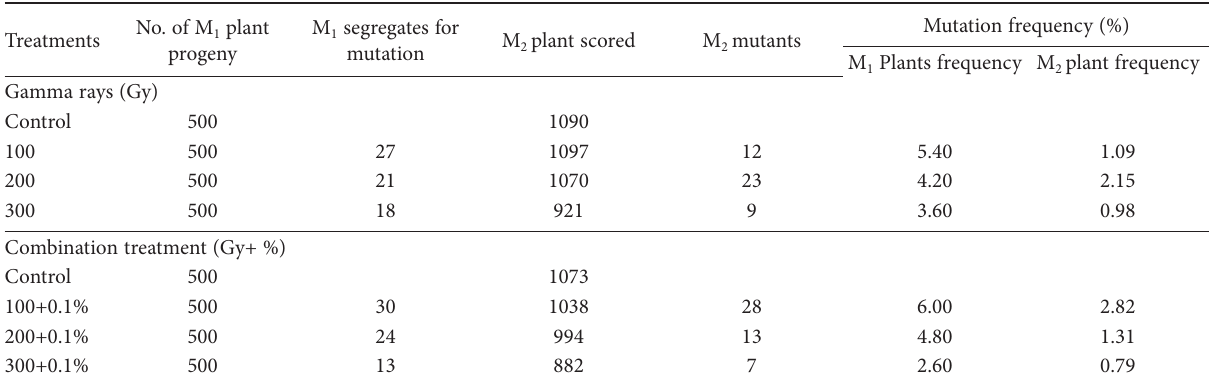
Table 1. Frequency of chlorophyll mutants induced through gamma and combination treatment (Gamma+EMS) in M 2 generation of Arte- misia annua